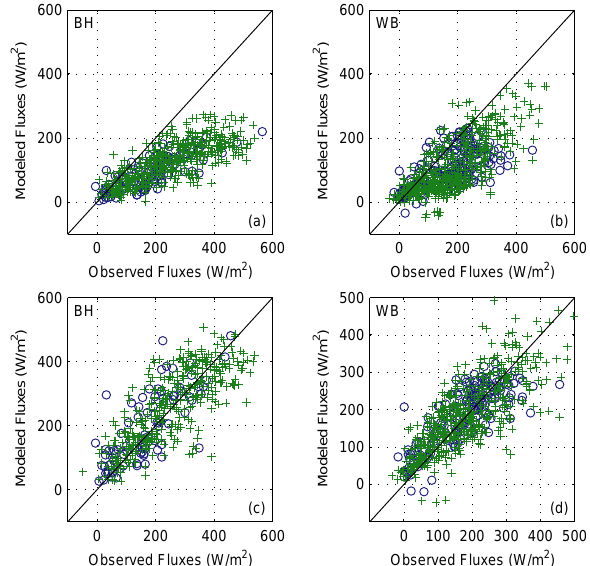
Fig. 2. Instantaneous modelled sensible heat flux during the growing season (crosses) and senescence (circles) with DTD driven by field measured LST with t 0 at one hour past sunrise at coniferous forest (BH, a and c ) and deciduous forest (WB, b and d ). The top panels – with f g = 1 and α PT = 1 . 26 for all vegetation types; bot- tom panels – with f g adjusted based on MODIS VI. Senescence at BH starts between day of year (DOY) 142 and 359 and at WB between DOY 240 and